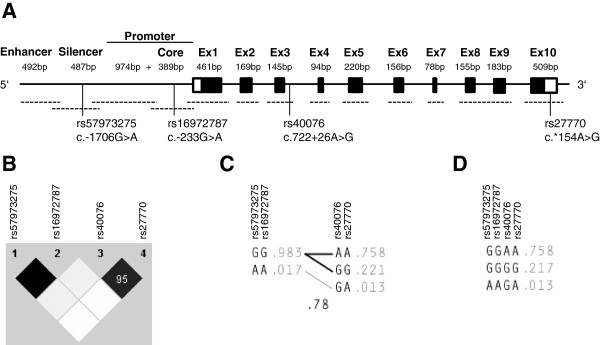
The PLK1 gene locus and genetic variants. Structure of the PLK1 gene (panel A). Black boxes represent exons, the size of exons and regulatory regions are given in base pairs (bp), they are not drawn to scale. The 5′ and 3′UTR are highlighted in white. Sequenced regions are depicted by dashed lines. Positions of PLK1 polymorphisms are given according to the nomenclature of the Human Genome Variation Society [26]. Haploview plot of the linkage disequilibrium analysis of PLK1 polymorphisms in 120 healthy Caucasians (panel B). Numbers in squares are D’ values in percent. If no number is given for a pairwise comparison D’ is 100 percent. Black color indicates an r2 of 1, shades of grey/black indicate an r2 between 1 and 0. White indicates an r2 of 0. Haplotypes of the two haplotype blocks (panel C) and across the PLK1 gene (panel D). The haplotype frequencies are shown to the right of each haplotype. Only haplotypes having a frequency > =1% are shown. Below the crossing area the multi-allelic D’, which indicates the level of recombination between the blocks, is shown. Connecting lines from one block to the other are shown for haplotypes with a frequency of at least 10% (thick lines) and with a frequency of at least 1% (thin lines), respectively.